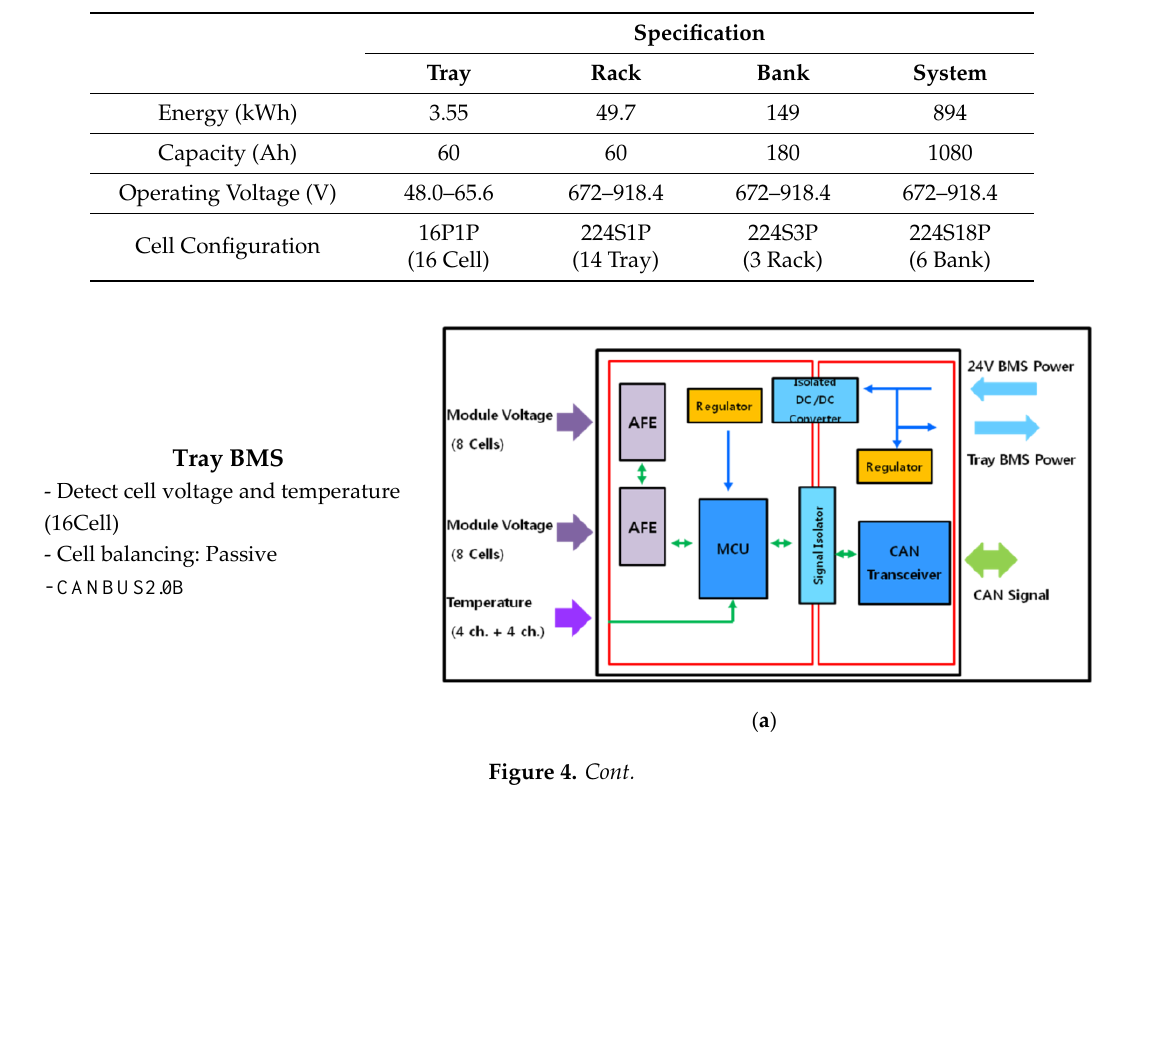
Figure 3. Simulation results of the daily operation of the peak power reduction system.